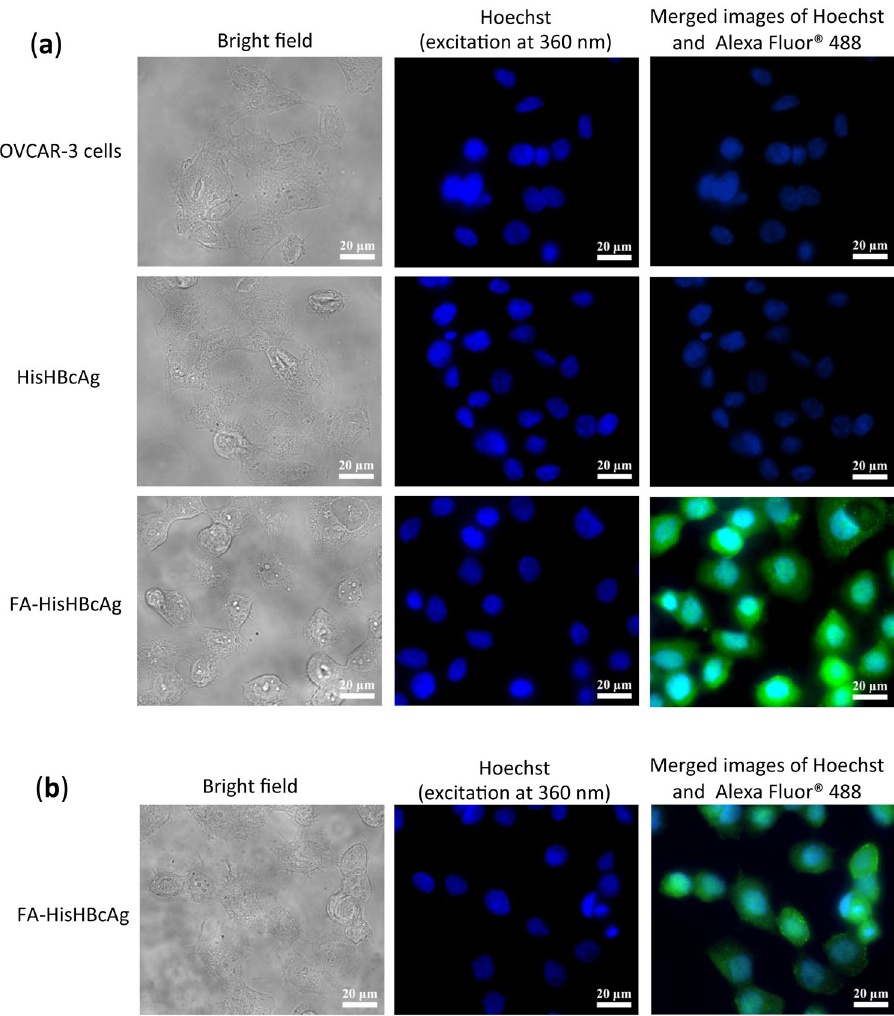
Figure 3. Internalisation of His-tagged VLNPs into OVCAR-3 cells. The HisHBcAg nanoparticles (HisHBcAg; 25 μ g) and folic acid (FA)-conjugated HisHBcAg nanoparticles (FA-HisHBcAg; 25 μ g) were incubated with OVCAR-3 cells for 16 h at 37 °C. The internalised HisHBcAg nanoparticles were detected by the rabbit anti- HBcAg serum, followed by anti-rabbit antibody conjugated to Alexa Fluor ® 488 ( a ), and the mouse anti-His antibody, followed by anti-mouse antibody conjugated to Alexa Fluor ® 488 ( b ). Cell nuclei were stained with Hoechst 33342. Non-transfected cancer cells served as a negative